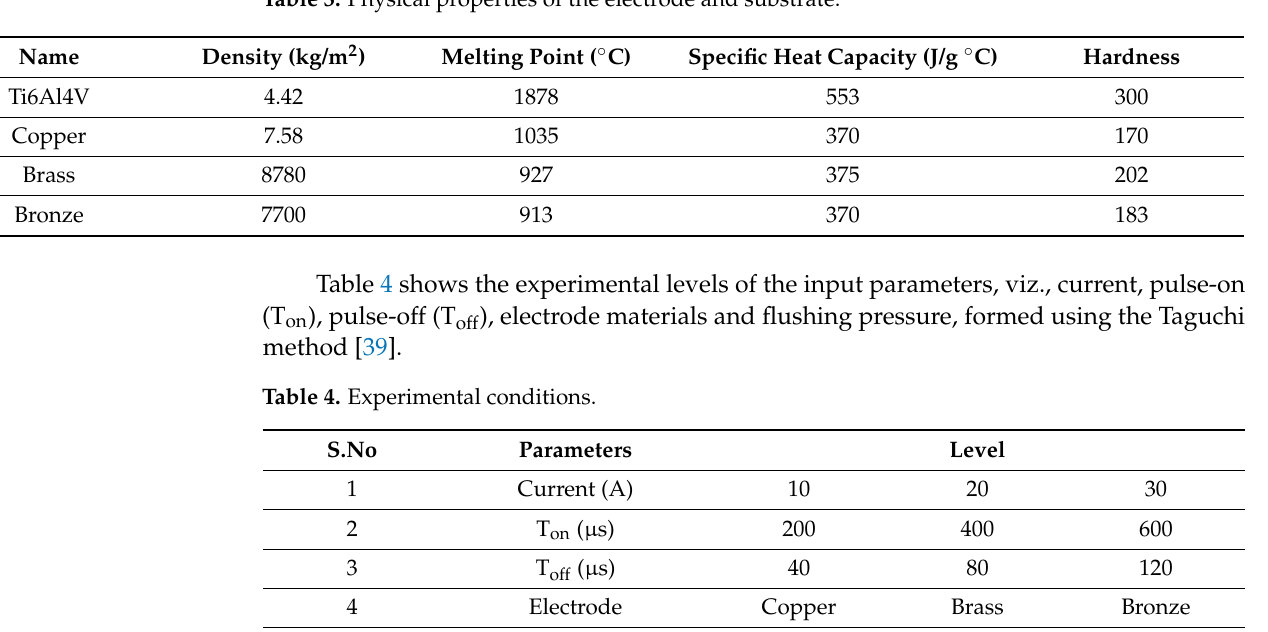
Table 3. Physical properties of the electrode and substrate.